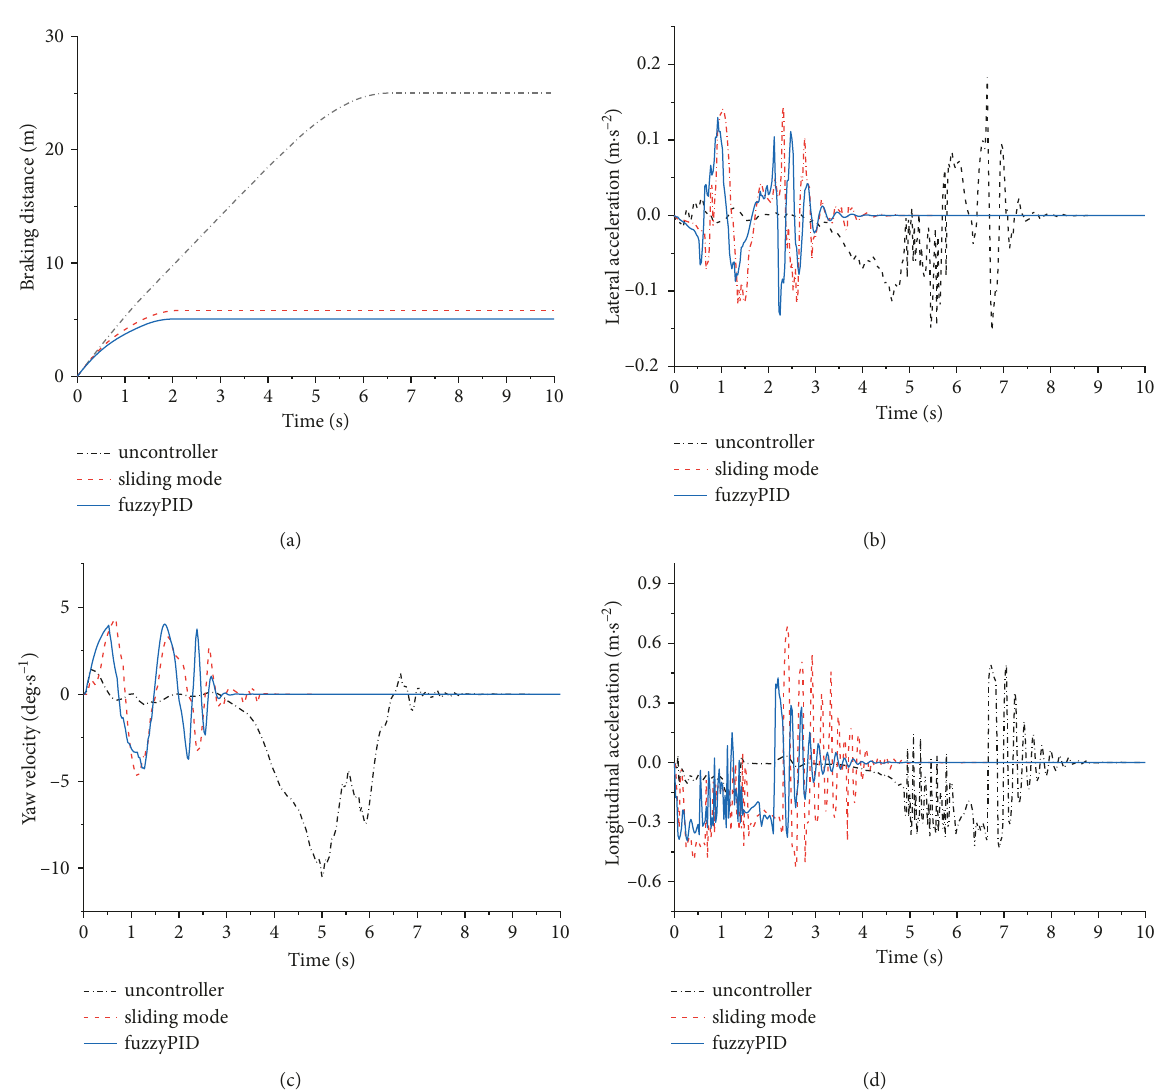
Figure 23: Simulation diagram of curve driving with braking efficiency of 70% at u � 0.75. (a) Braking distance. (b) Lateral acceleration. (c) Yaw velocity. (d) Longitudinal